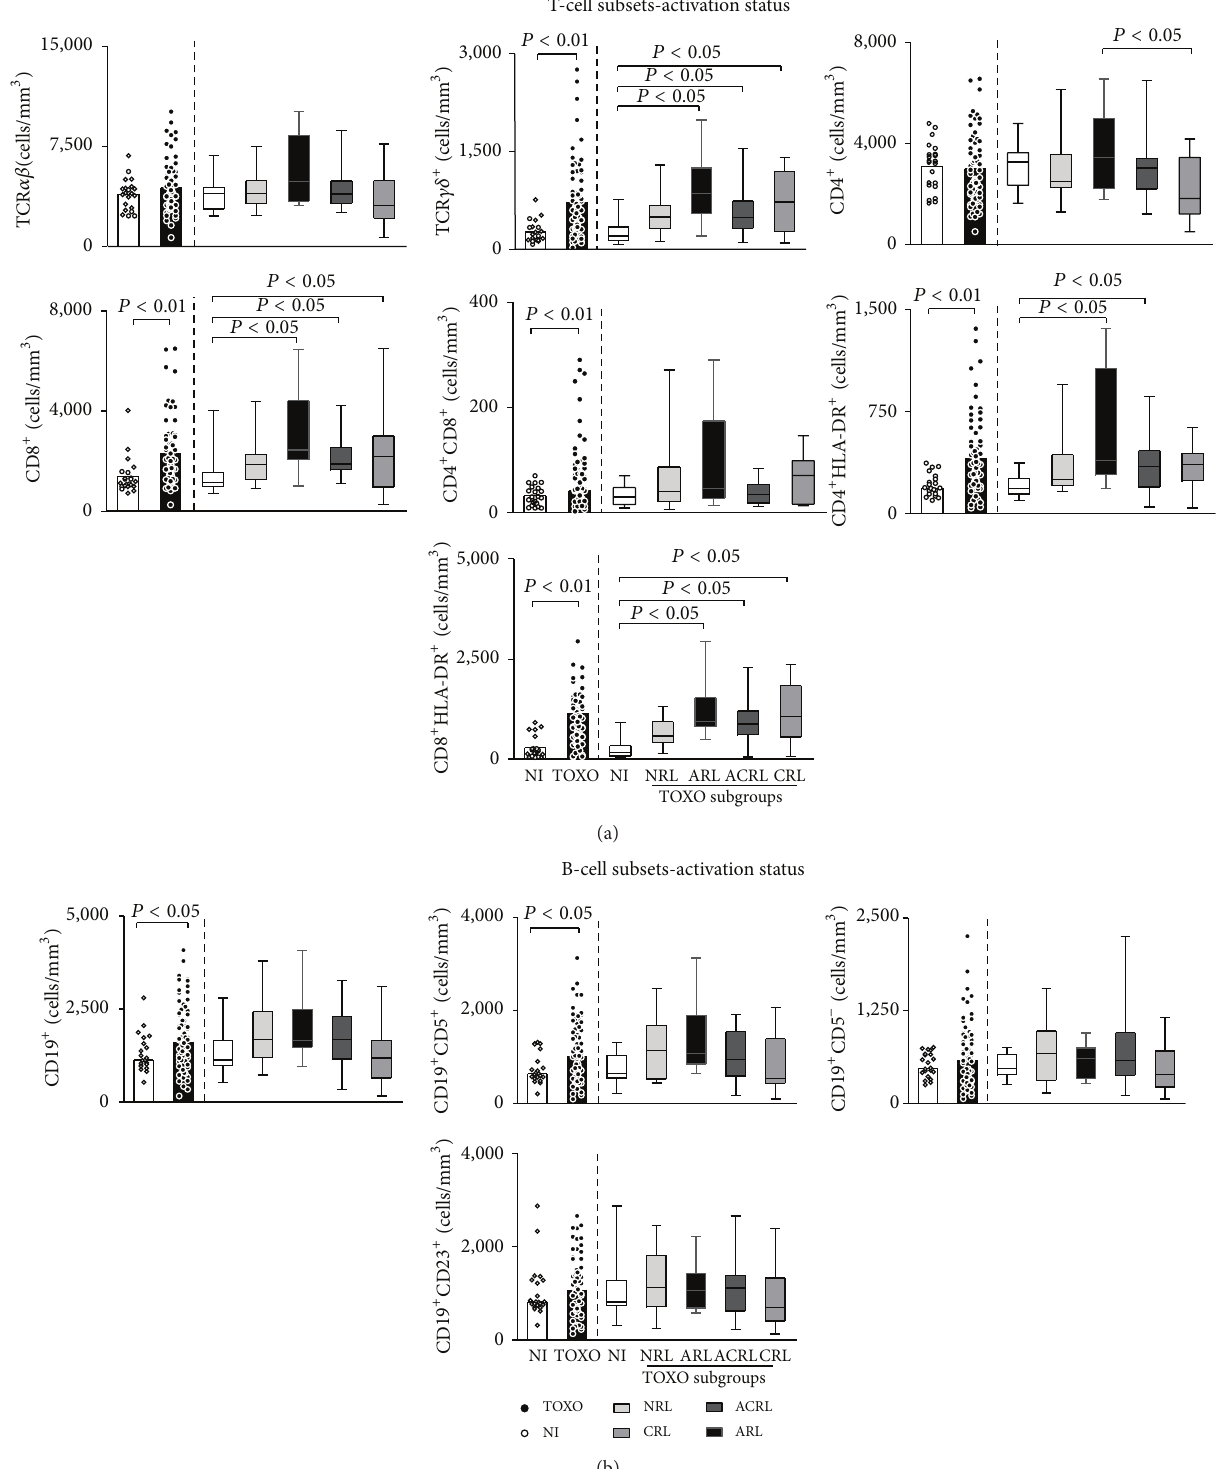
Figure 3: Major subsets and activation status of T- (a) and B-cells (b) in the peripheral blood of infants with congenital toxoplasmosis (TOXO) and noninfected controls (NI). Congenital toxoplasmosis was further categorized according to the clinical ocular status, referred to as no retinochoroidal lesions (NRL), active retinochoroidal lesions (ARL), active/cicatricial retinochoroidal lesions (ACRL), and cicatricial retinochoroidal lesions (CRL). The results are expressed as scatter plots of individual values and the medians of absolute cell counts/mm 3 (left side) or in box-plot format (right side), where the box stretches from the lower hinge (25th percentile) to the upper hinge (75th percentile), and the middle half represents the median of the distribution as a line across the box. Significant differences are highlighted by connecting lines, and 𝑃 values are shown in the